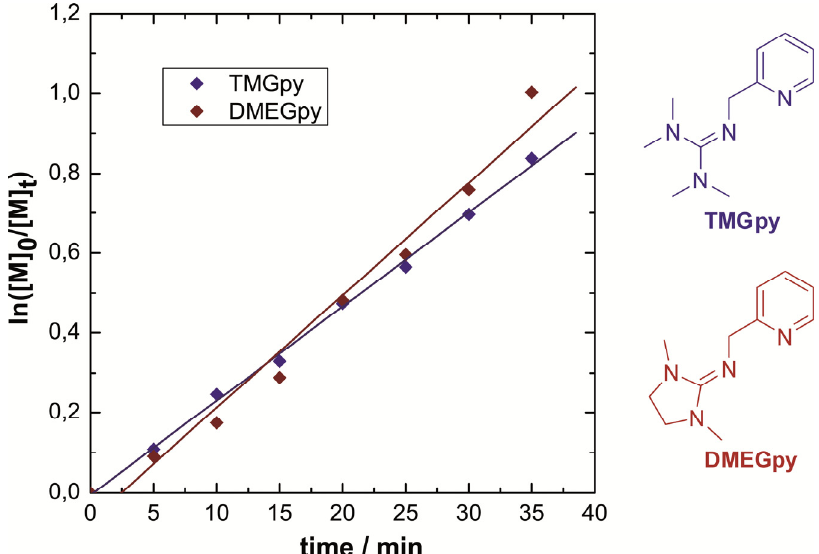
Figure 6. The semilogarithmic plot of the conversion against time for the styrene atom transfer radical polymerization (ATRP) mediated by 2 (tetramethylguanidine)methylenepyridine (TMGpy) (blue)/2 DMEGpy (red) and CuBr and 1-phenylethylbromide (PEBr) as the initiator at 110 °C. The ratio of styrene:ligand:CuBr:PEBr =